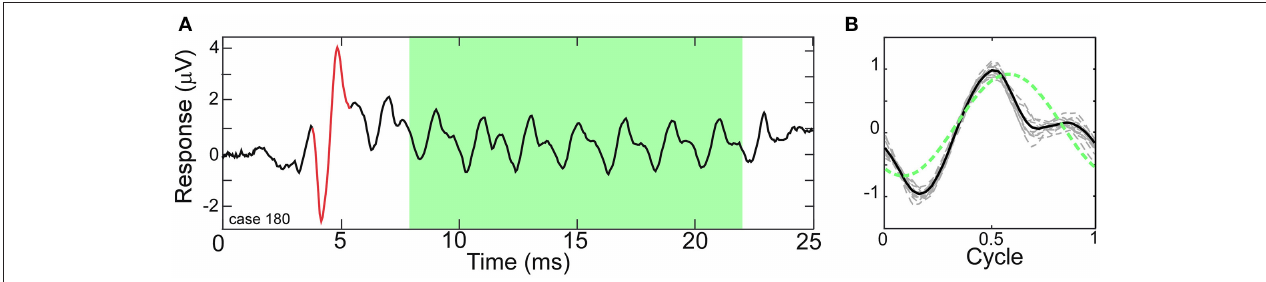
FIGURE 1 | Electrocochleography (ECochG) response to a tone burst from a human CI subject. (A) A Human ECochG response to a 500Hz tone burst presented in condensation phase. The ongoing portion is highlighted (green area). The CAP is shown in red. (B) Each cycle in the ongoing response (dashed lines) and the “average cycle” (solid line). The presence of the ANN causes distortions in the response compared to a reference sinusoid (dotted